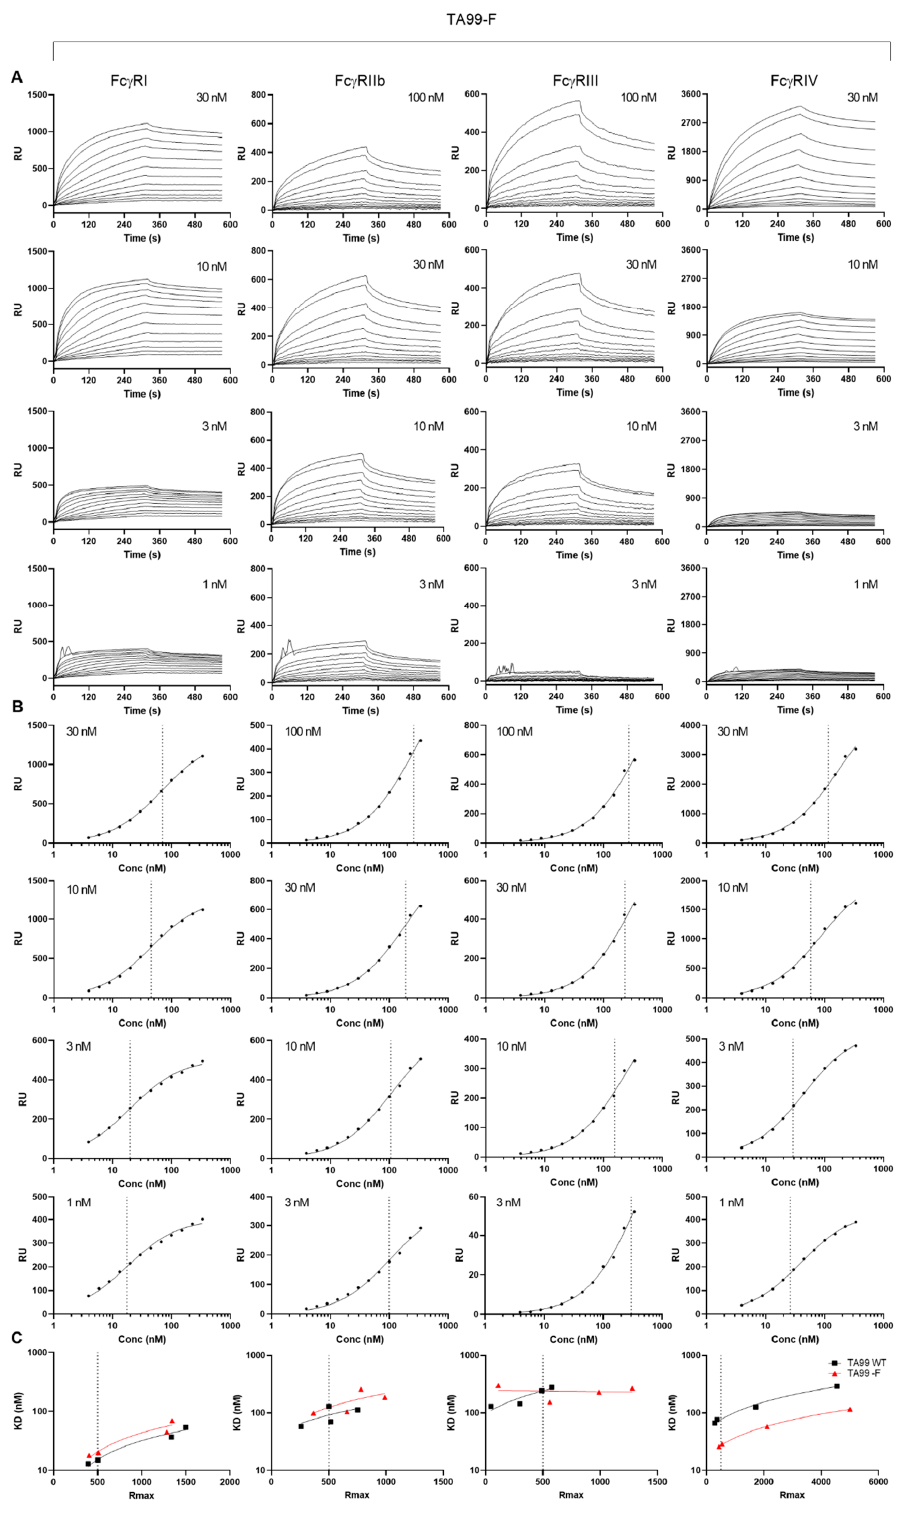
Figure 5. Affinity plots for afucosylated human IgG1 to mouse Fc γ R: Lack of fucose in the Fc domain results in increased binding to mouse Fc γ RIV. Experiment was carried out as described for Figure 4, with ( A ) Sensorgrams and ( B ) derived affinity plots for 4 different ligand (Fc γ R) concentrations as indicated. ( C ) The derived KD from each affinity plots for fucosylated hIgG1 (Figure 4B) and afucosylated IgG1 from ( B ) and Rmax of each ligand concentration plotted for interpolation of KD for both fucosylated and afucosylated IgG1 to a constant Rmax of 500 (vertical lines, tabulated in Table